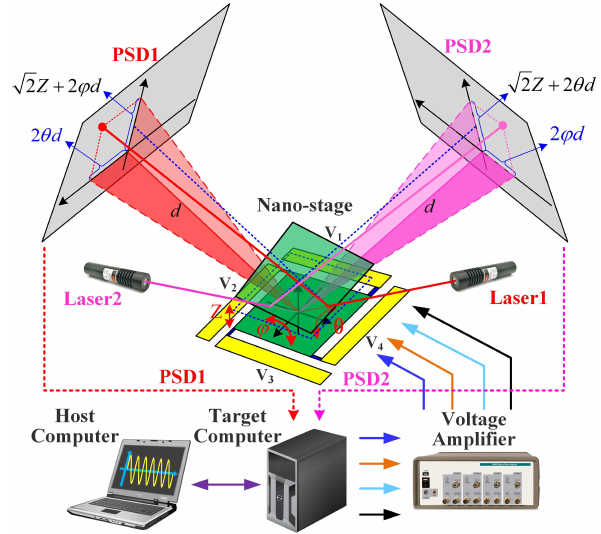
Figure 8. Schematic diagram of the detection method and the experimental setup.